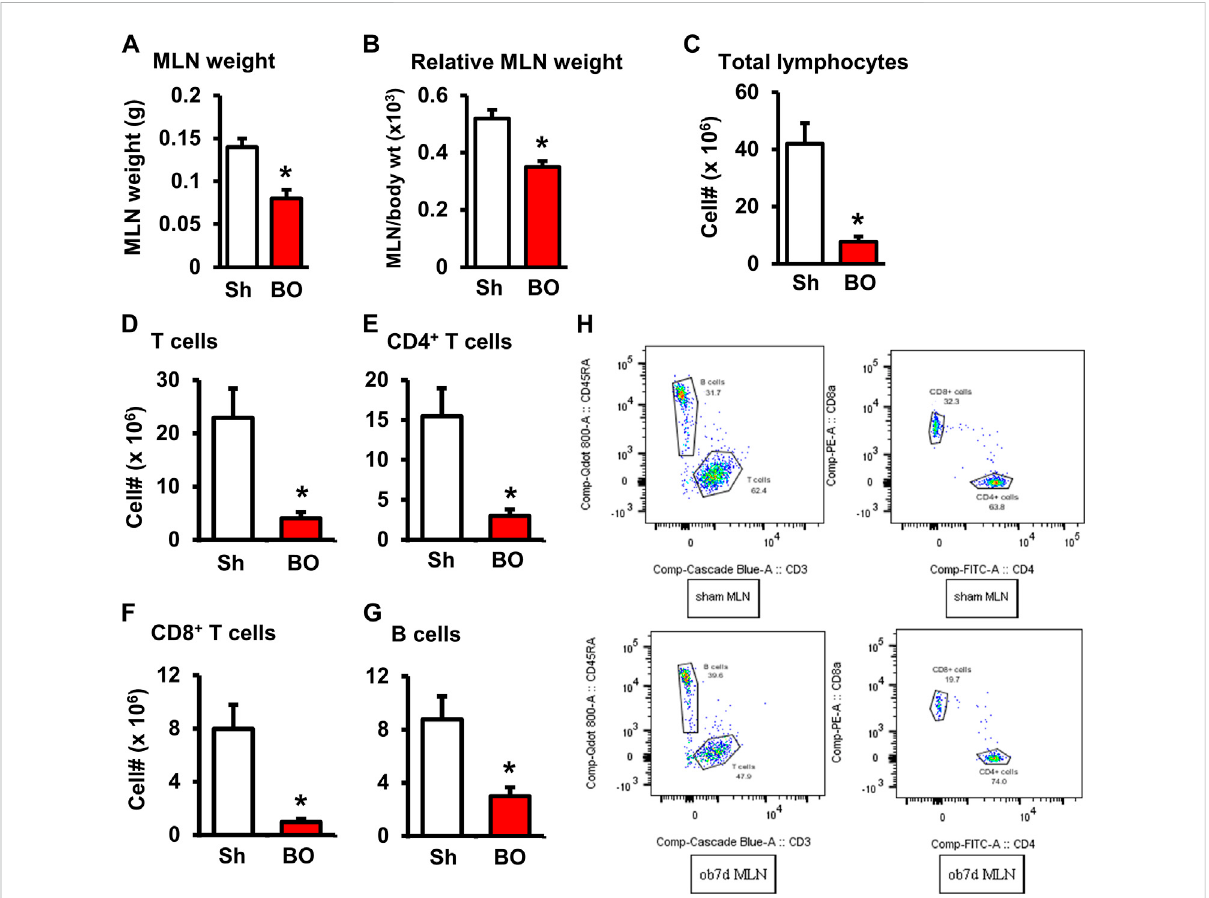
FIGURE 2 Effect of bowel obstruction on the mesenteric lymph node. (A) Weight of isolated mesenteric lymph node (MLN) in sham rats (Sh) and rats with bowel obstruction (BO) for 7 days. (B) Relative weight of the MLN [Ratio of MLN weight/body weight (x 10 3 )]. (C) Total live cells in the MLN. (D) Total Tcells(CD3 + ); (E) CD4 + cells(CD3 + /CD4 +) ; (F) .CD8 + cells(CD3 + /CD4 + ); (G) Blymphocytes(CD45RA + ). (H) Representative fl owcytometrypro fi lesfor B and T lymphocytes in sham (upper left) and BO rats (down left), and CD4 + and CD8 + cells in sham (upper right) and BO rats (down right). N